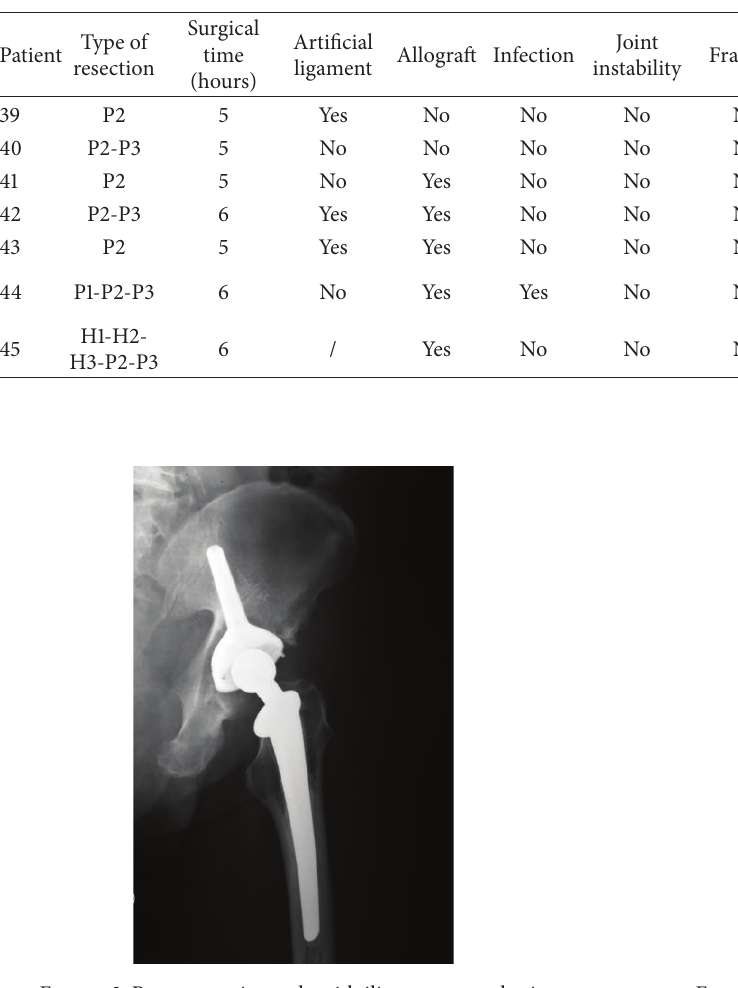
Figure 3: Reconstruction only with iliac stem prosthesis.